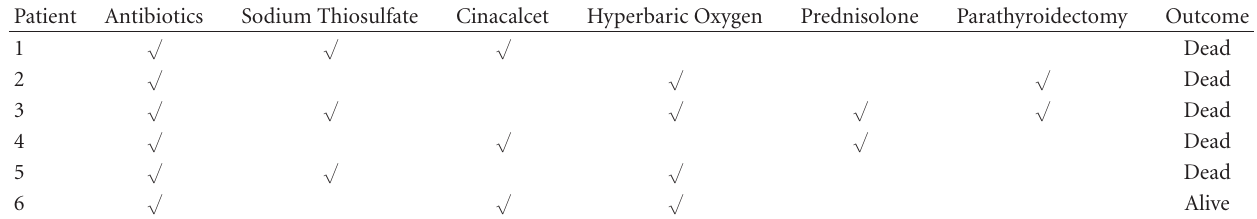
Table 3: Multimodal care and outcome in subjects with calcific uremic arteriolopathy.